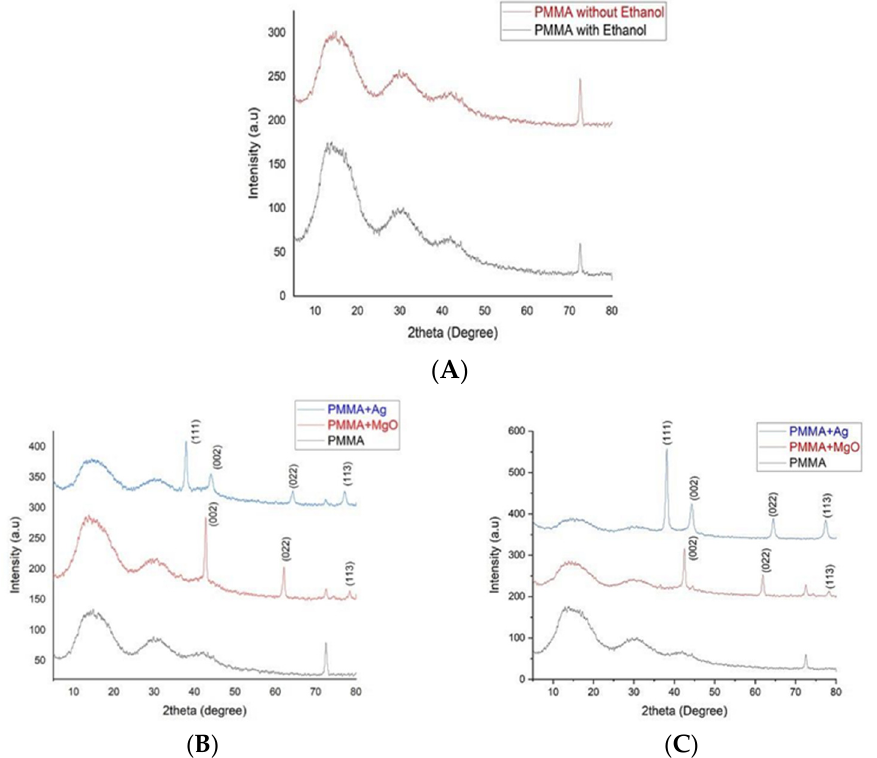
Figure 2. XRD test for study groups: ( A ) control group; ( B ) non-ethanol-assisted mixing; and ( C ) ethanol-assisted mixing.